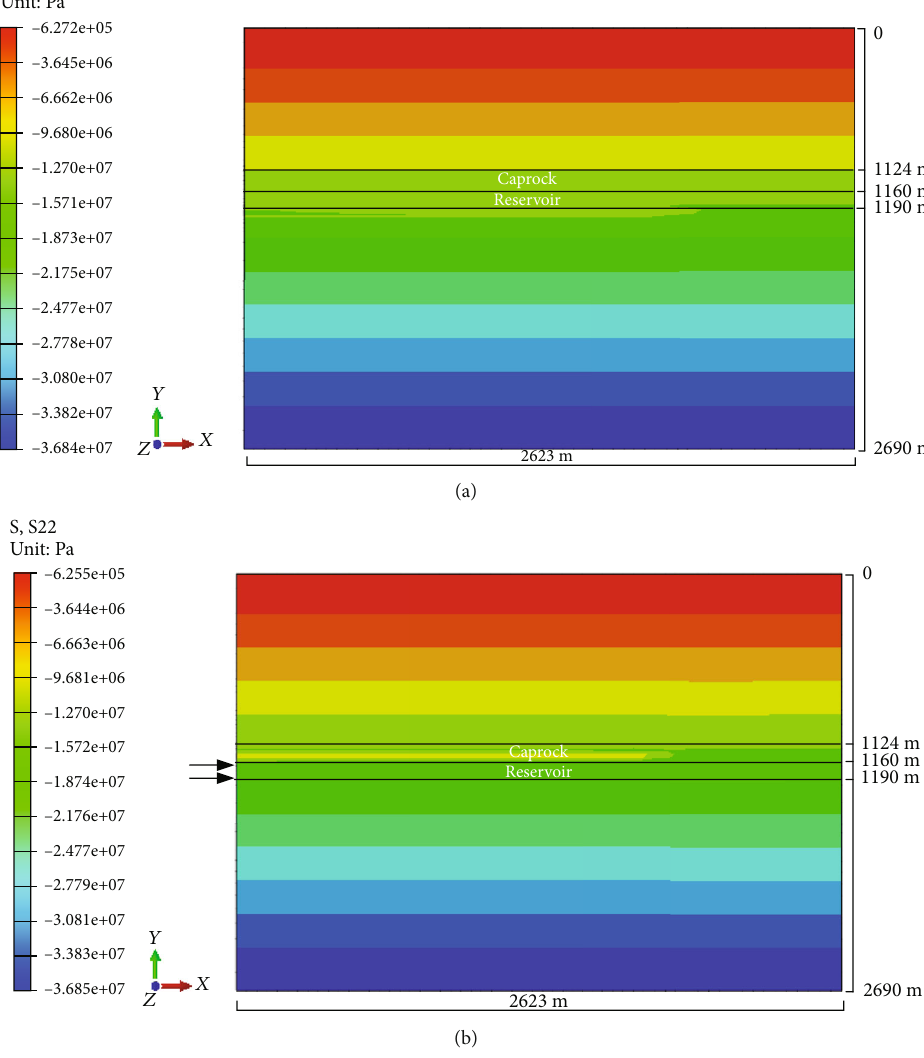
Figure 9: Vertical stress nephogram. (a) Before injection. (b) After